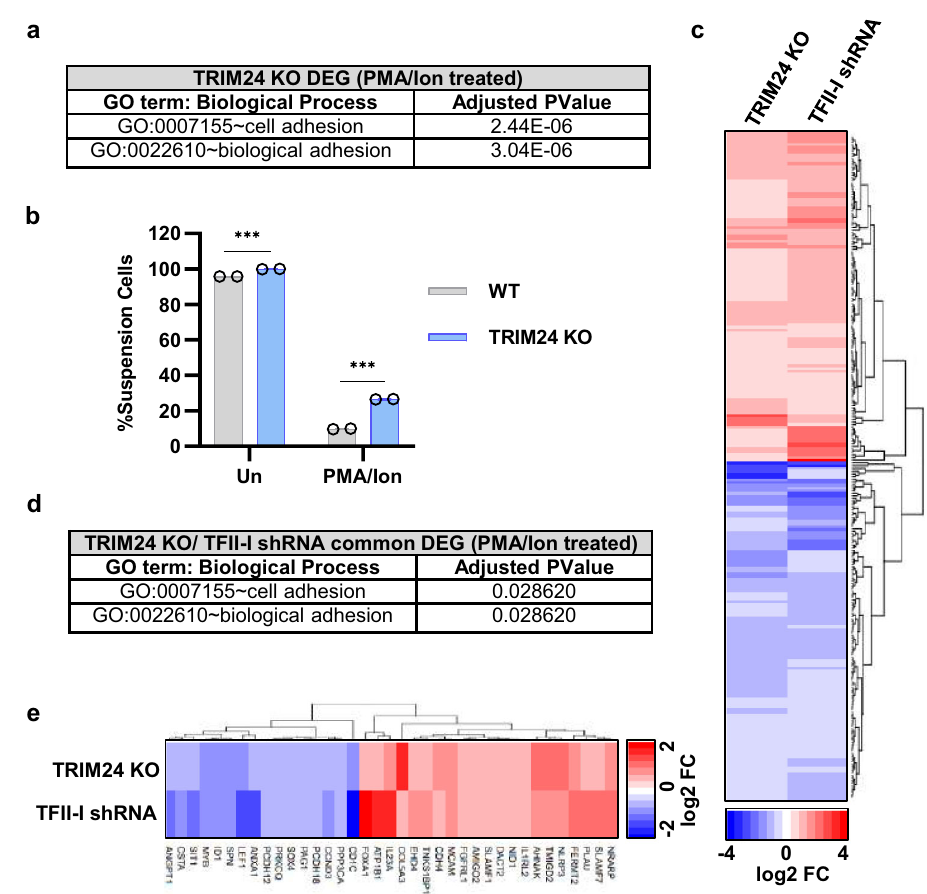
Fig. 9 TFII-I enhances the TRIM24 transcriptional program. a PMA/ionomycin-treated TRIM24 KO DEG display enrichment of cell adhesion-related biological processes as identi fi ed with DAVID online tool gene ontology analysis. b Wild-type or TRIM24 KO Jurkat Tat T cells were left untreated or stimulated with 20 nM PMA/1 μ M ionomycin for 2 h. The proportion of cells that adhered to the fl ask culture surface or remained in suspension was determined ( n = 2, mean ± SD). c Heatmap depiction of signi fi cantly downregulated (blue) or upregulated (red) genes that are common to TRIM24 KO and TFII-I knockdown cells (PMA/ionomycin-treated). Relative gene expression was determined by DESeq2 analysis of n = 3 RNA-seq samples. d DAVID online tool gene ontology analysis of TRIM24 KO and TFII-I knockdown common DEG (PMA/ionomycin-treated) identi fi ed enrichment of cell adhesion- related biological processes. e Heatmap showing signi fi cantly downregulated (blue) or upregulated (red) genes that are common to TRIM24 KO and TFII-I knockdown (PMA/ionomycin-treated) and are involved in cellular adhesion. n = 3 RNA-seq samples were analyzed by DESeq2 to determine relative gene